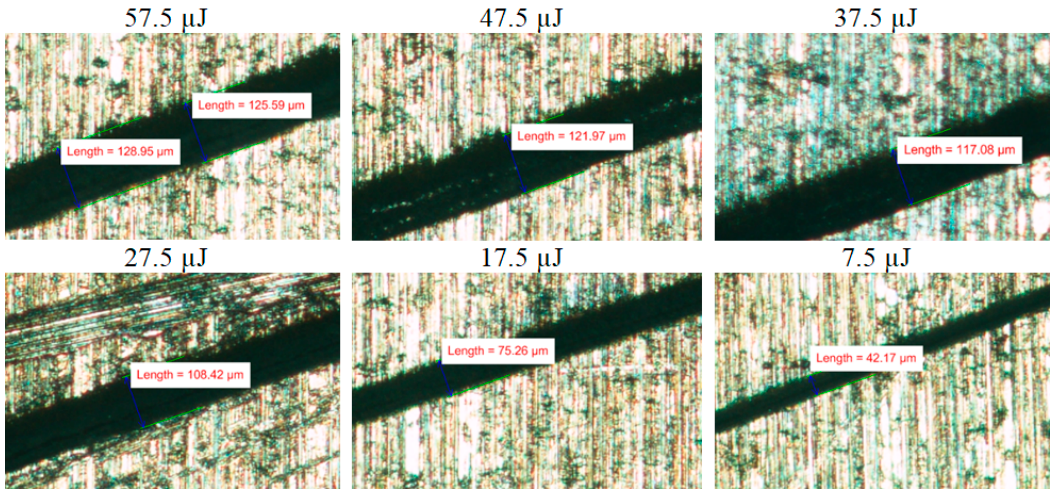
Figure 2. Aluminum sample scribed with sub-picosecond Yb:KYW laser (650 fs, 1030 nm, 200 kHz). Appl. Sci. 2020 , 10 , x FOR PEER REVIEW